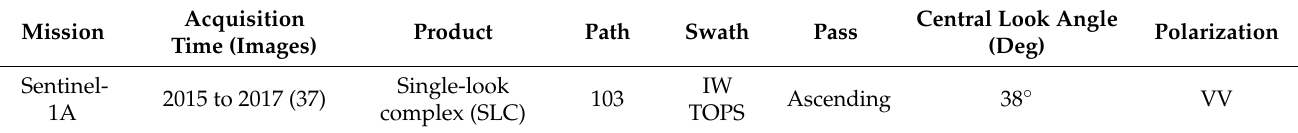
Table 1. Specifications of the radar